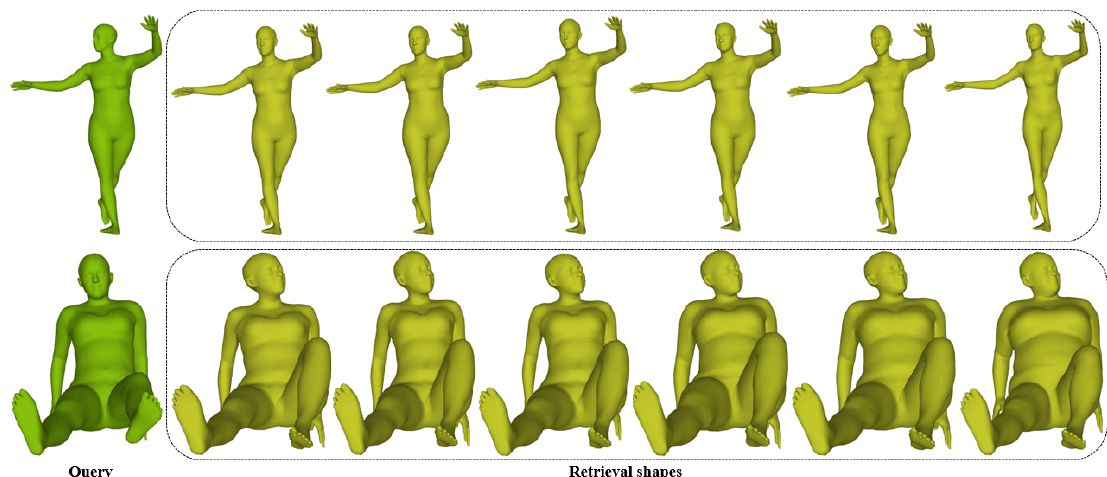
Figure 15. Pose retrieval: For the query 3D human shapes (left one), our method retrieves the first six best shapes who have similar poses to the query one in the HPRD dataset.